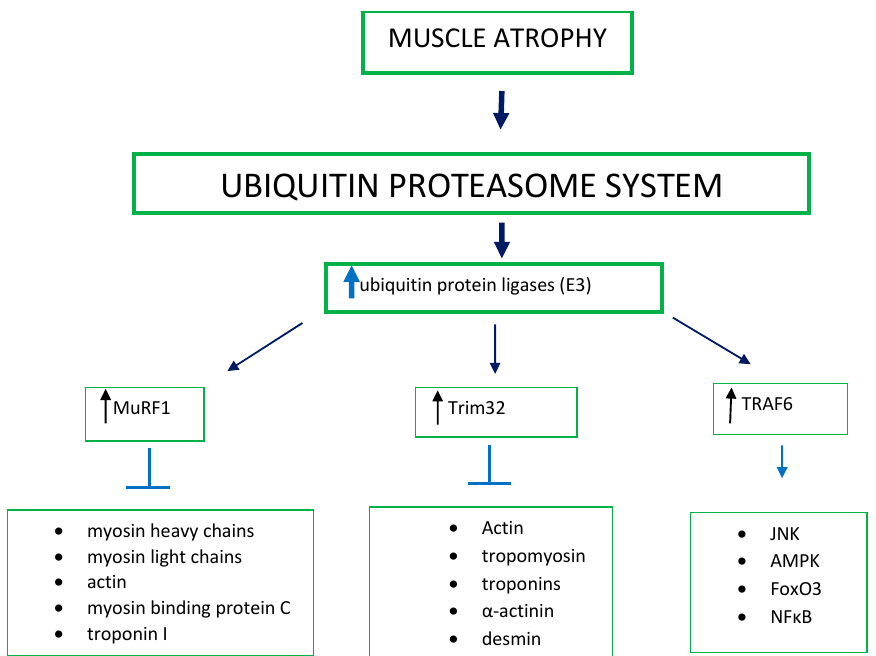
Figure 1. Ubiquitin-proteasome system and muscle atrophy. Principal mechanisms and different factors involved. The arrows up into the boxes indicate an increase of expression.